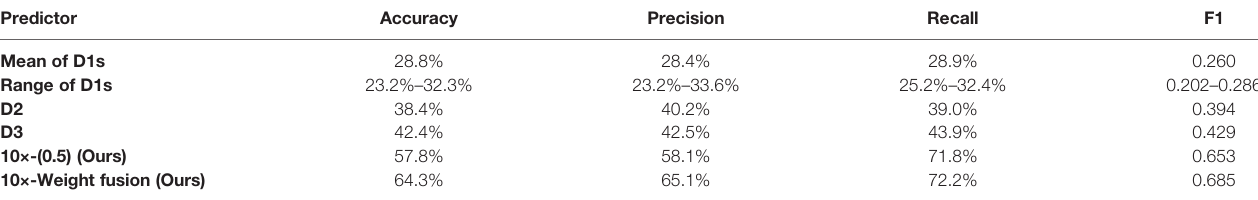
TABLE 2 | Comparison of molecular subtyping results among doctors and our best models. Predictor Accuracy Precision Recall Mean of